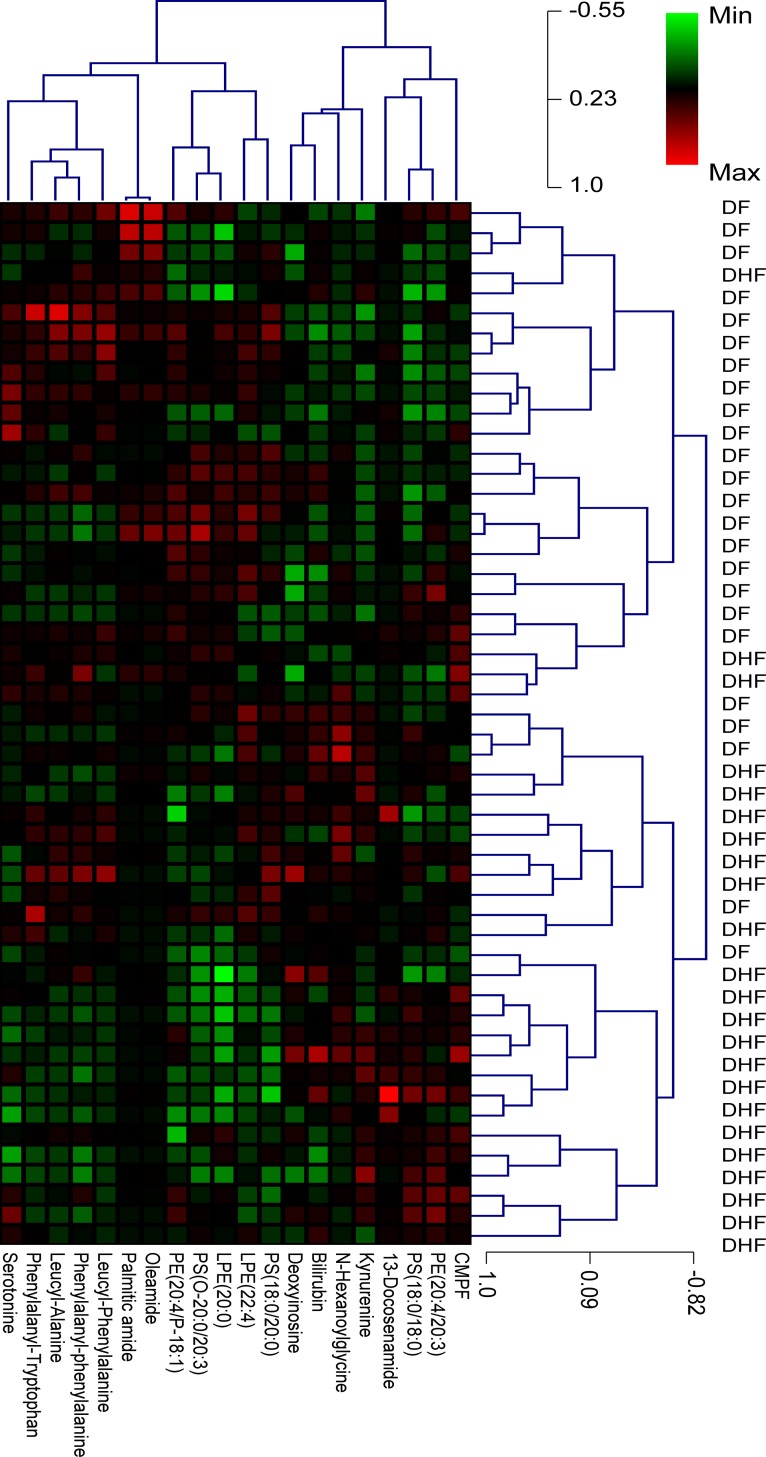
Hierarchical heatmap clustering with identified differential metabolites segregates febrile phase dengue fever (DF) and dengue hemorrhagic fever (DHF) patients.Each column shows ion intensity for a specific metabolite after mean centering and unit variance scaling of the data. Each row shows the serum metabolic profiles of DF and DHF patients.